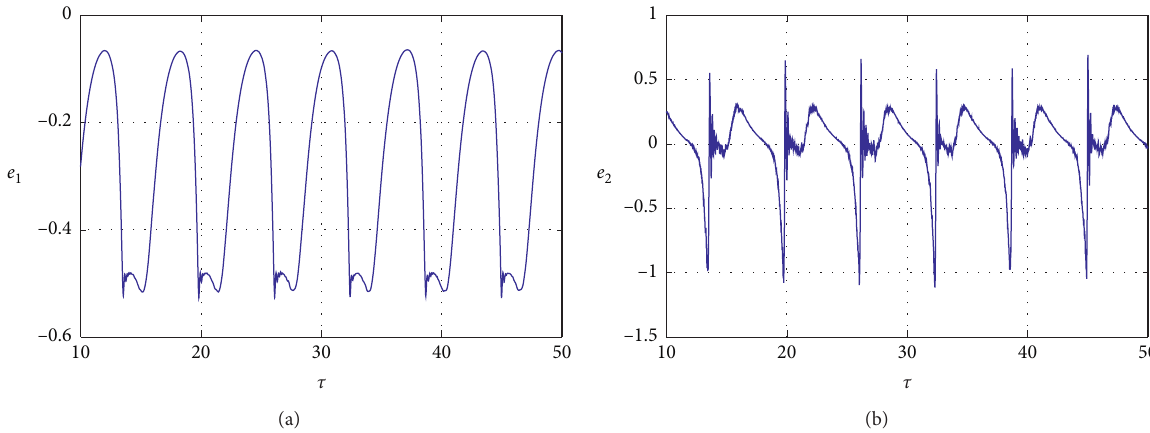
Figure 13: Deviation of the desired trajectory with the proposed control with parametric errors in feedback control u by SDRE and feedforward control 􏽥 u . (a) Deviation of the desired trajectory e 1 ; (b) deviation of the desired trajectory e 2